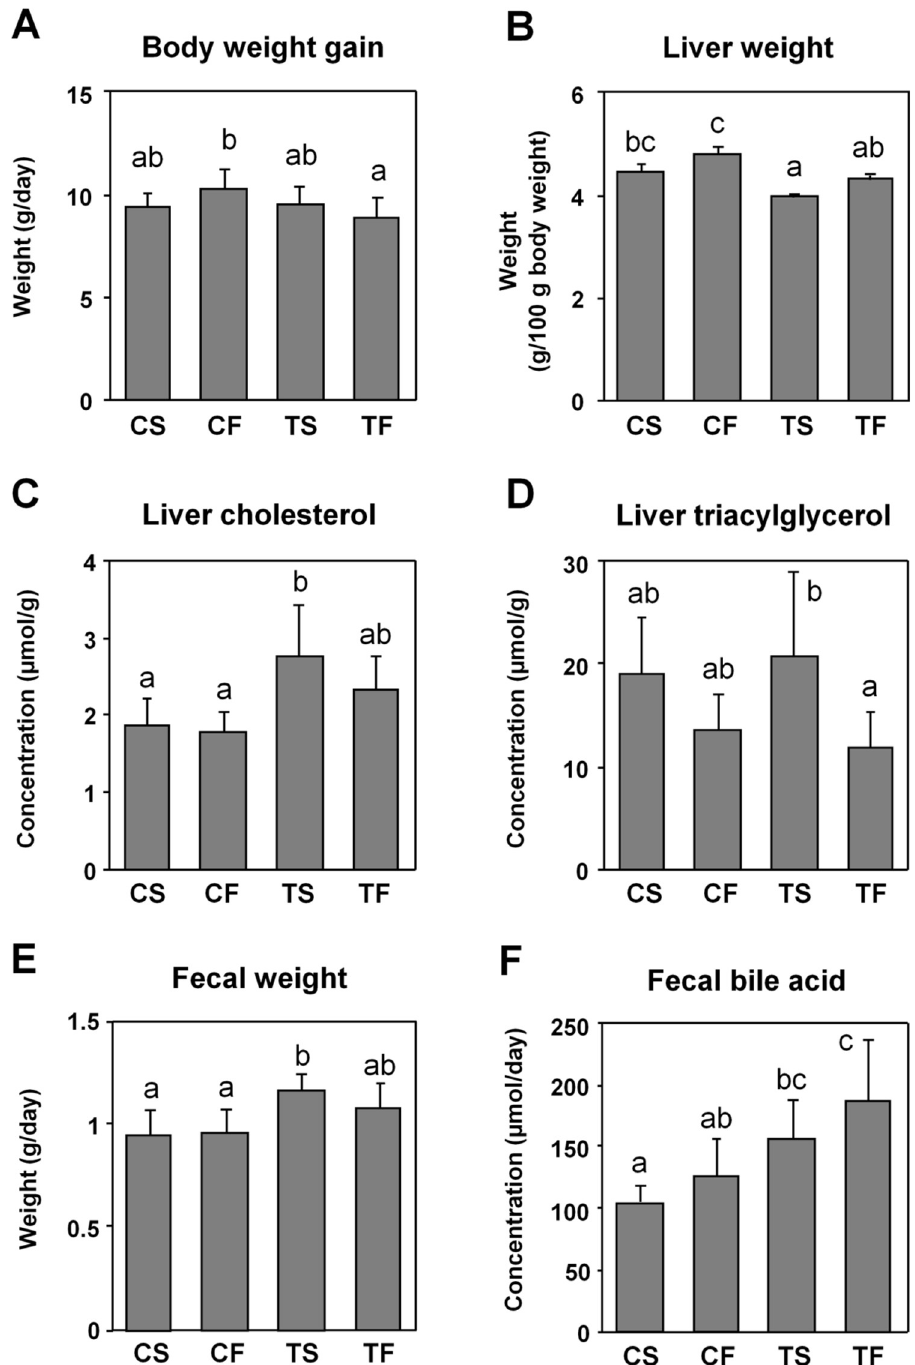
Fig 1. Growth and biochemical parameters of rats. ( A ) Body weight gain during the experimental period. ( B ) Liver weight in the experimental period. ( C ) Cholesterol and ( D ) TG levels in the liver. ( E ) Daily lyophilized fecal weight. ( F ) Fecal bile acid levels. C, Casein; T, tofu; S, soy oil; F, fish oil. Values are means ± SD, n = 7–8. Means without a common letter significantly differ, p < 0.05.